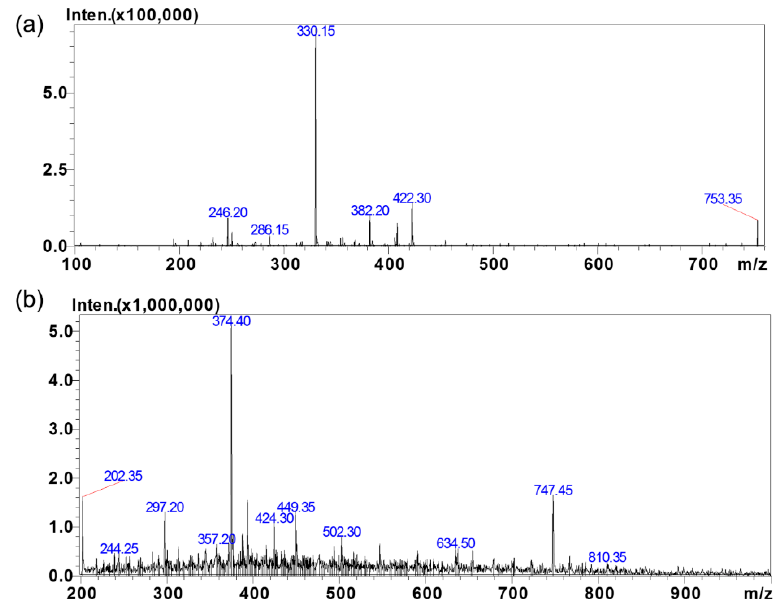
Figure 2. MS/MS product ion spectra; ( a ) precursor ion peak for ICG in positive ESI mode [M+H] at m / z 753.35 and ( b ) precursor ion peak for Cy7.5 in positive ESI mode [M+H] peak at m / z 747.45.